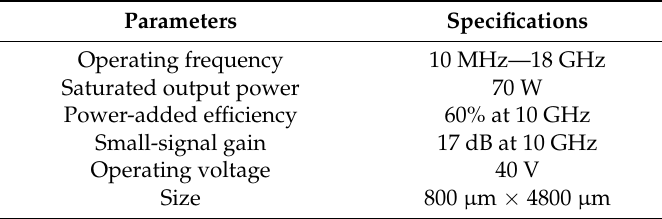
Figure 1. Photograph of a GaN high electron mobility transistor (HEMT) (CGHV1J070D) from Wolfspeed. Table 1. Main performance parameters of CGHV1J070D.